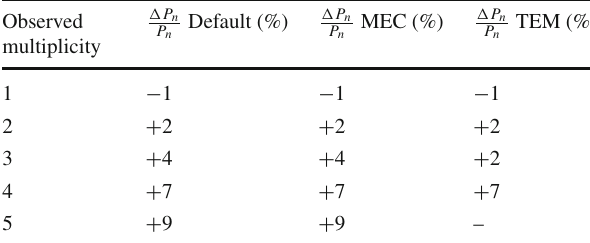
Table 8 Relative change in observed multiplicity probabilities corre- spondingtoincreasingtheconditionalprobabilityforreconstructingthe long track by 3% for each additional track found in the event, as sug- gestedbyPandorastudiesofQEandchargedpionresonanceproduction for three GENIE models: default, MEC, and TEM. The missing entry for observed multiplicity 5 in TEM is due to no event being generated with that observed multiplicity Observed